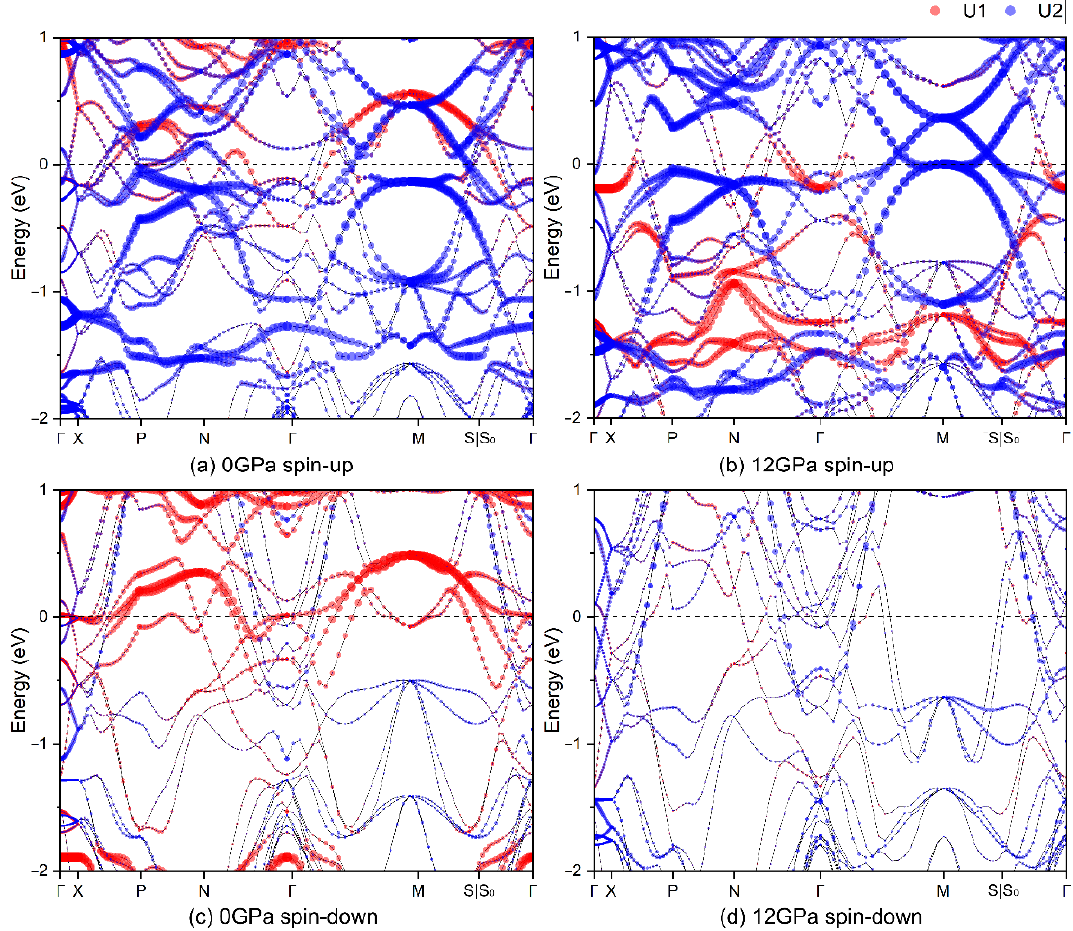
Figure 7. The spin-up and spin-down band structures of U 3 Si 2 C 2 at 0 GPa and 12 GPa. The projection on U1 and U2 atoms are included. The dash line represents Fermi surface.